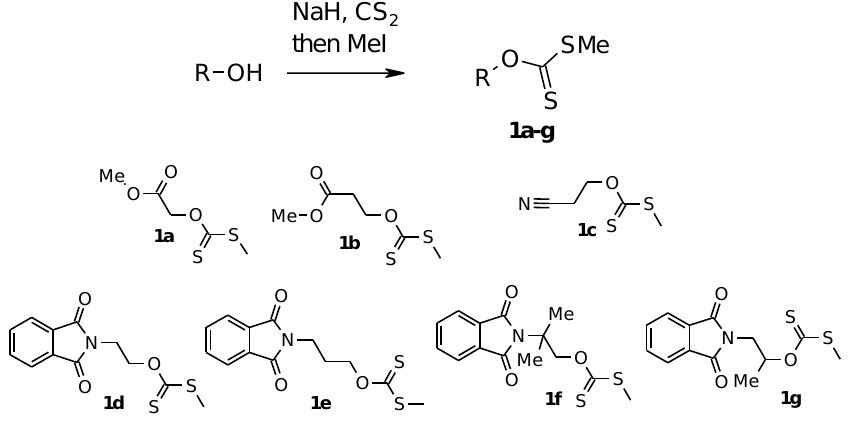
Scheme 1. Synthesis and structures of